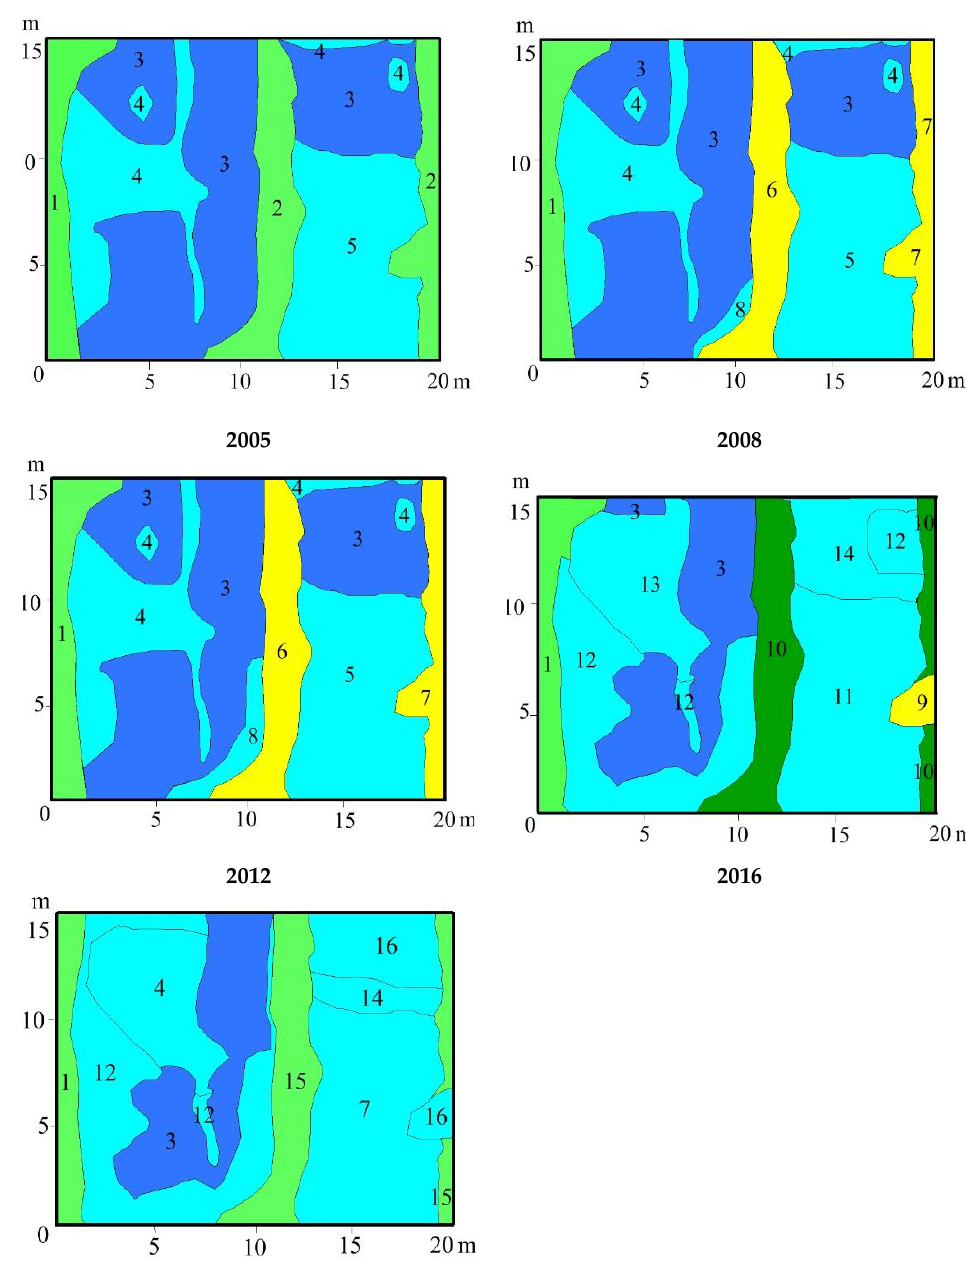
Figure 11. Changes in vegetation on permanent plot No. 5: 1 Pinus sylvestris – Vaccinium uliginosum + Eriophorum vaginatum ; 2 P. sylvestris – Andromeda polifolia + E. vaginatum – Sphagnum fallax ; 3